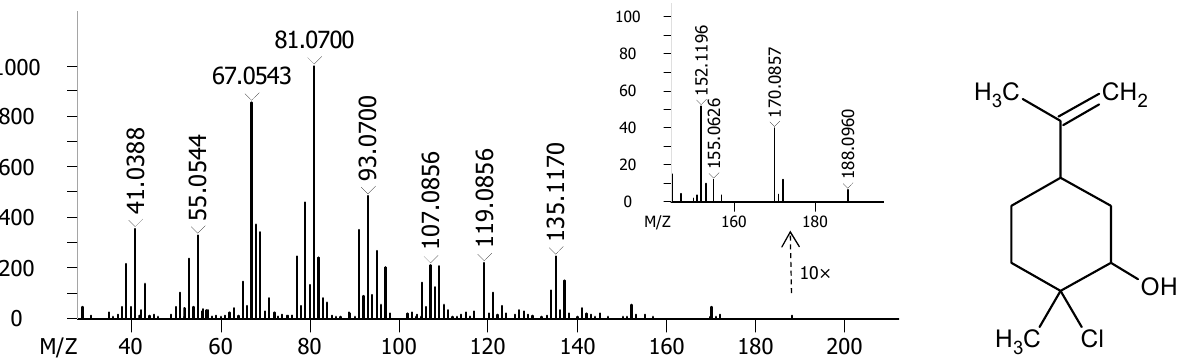
Figure 4. Mass spectrum and formula of 2-chloro-2-methyl-5-(1-methyletenyl)cyclohexanol with RT 837 s.